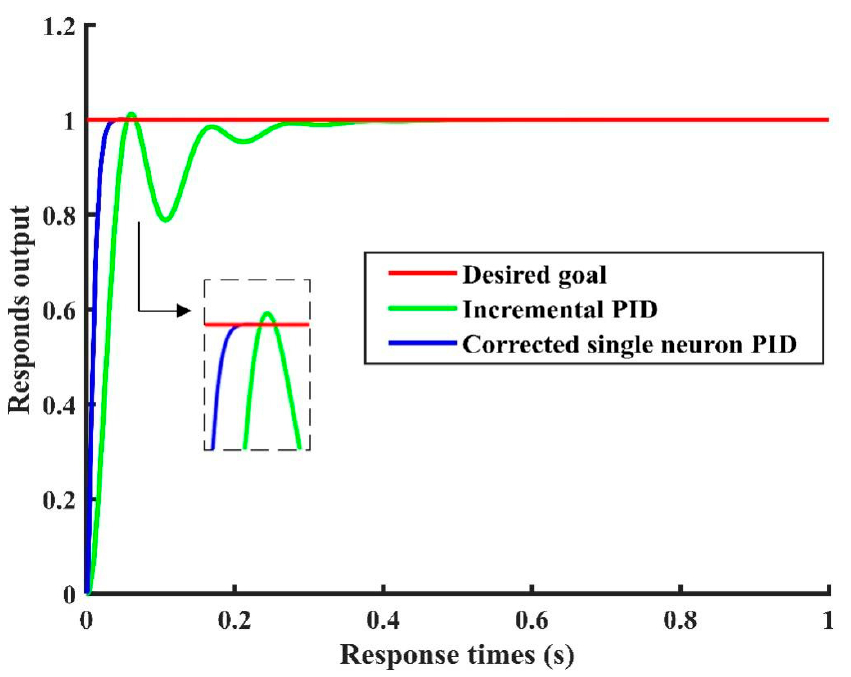
Figure 9. Step response graph. Note: Y -axis is response to the output during a step response. Table 5. Key performance indicators of the step response.